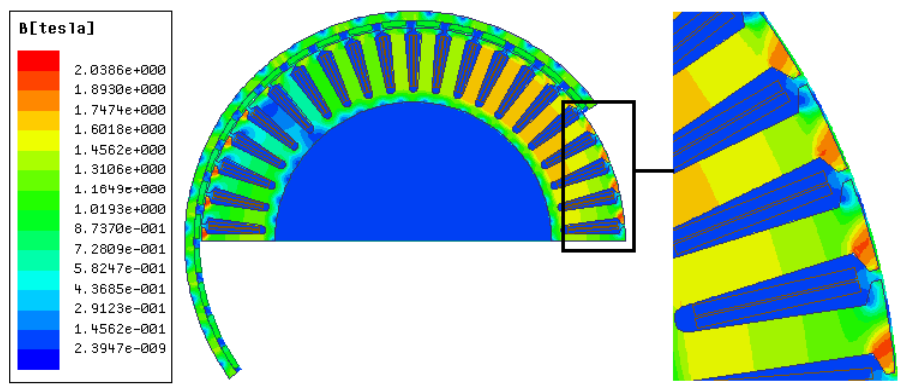
C 相 Figure 17. Waveform of three-phase flux linkage under no-load. 0 C 相 Figure 18. Waveform of three-phase back electromotive force under no-load. 3.3.2. Analysis of the Load Transient Magnetic Field